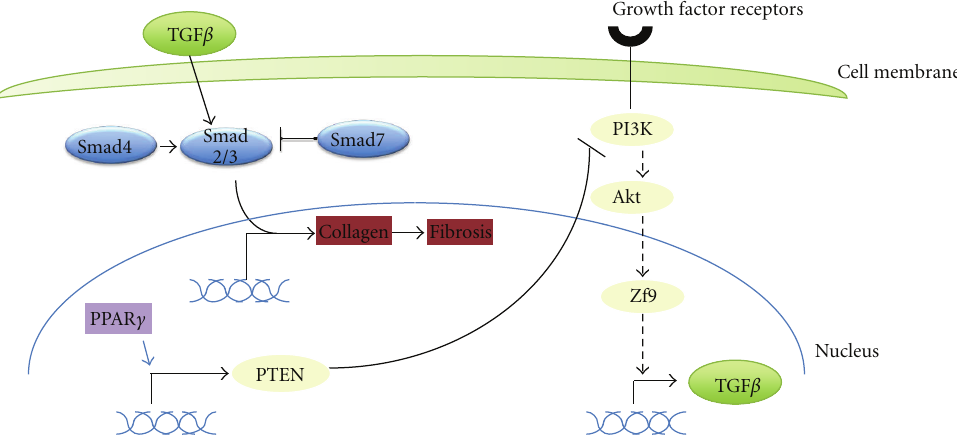
Figure 6: The role of PPAR γ in the pathogenesis of fibrosis. PTEN induction by PPAR γ inhibits the PI3K/Akt pathway downregulating transcription factor Zf9, an inducer of TGF β . Resulting decrease of TGF β signaling leads to a decrease of collagen production. UPS regulates all these pathways (not